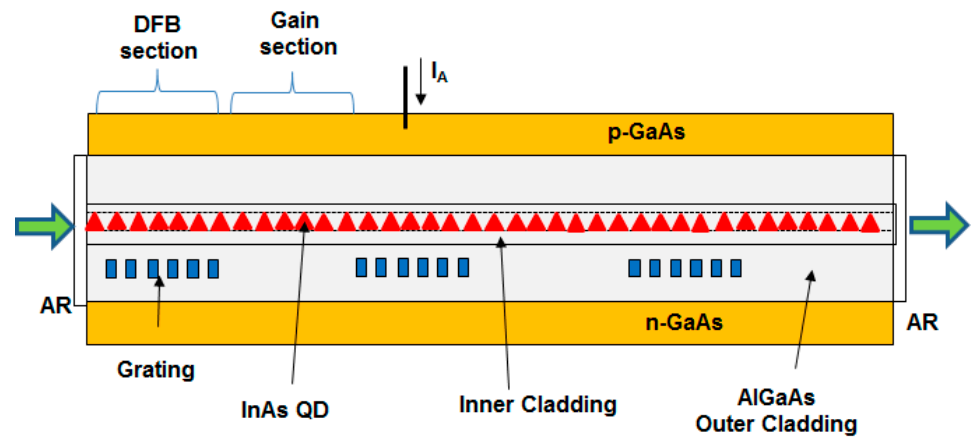
Figure 1. Schematic of sample-grating quantum-dot-distributed Bragg semiconductor optical amplifier.